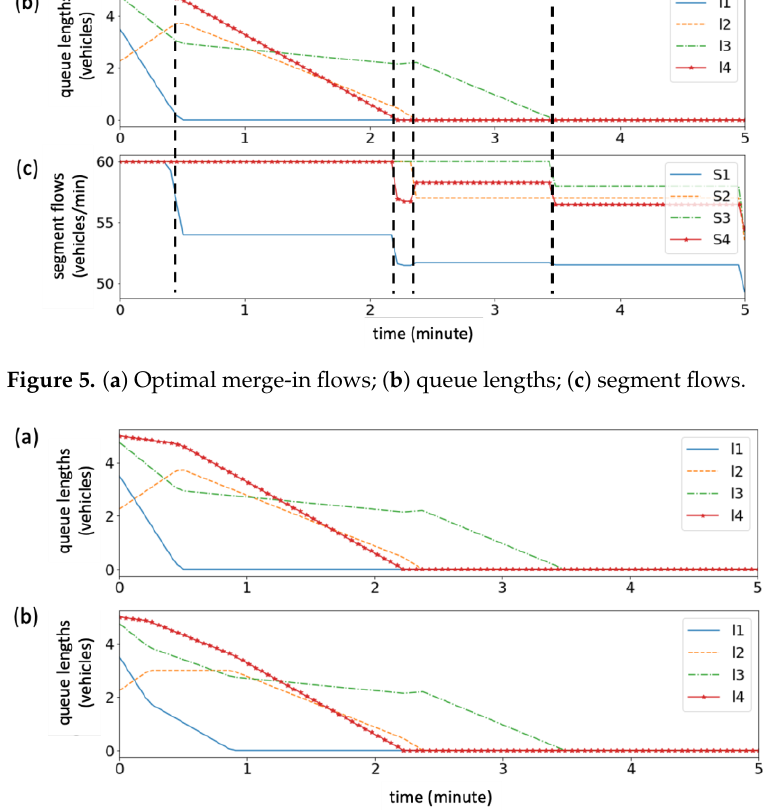
Figure 6. Queue length evolution: ( a ) without queue length upper bound; ( b ) with queue length upper bound.